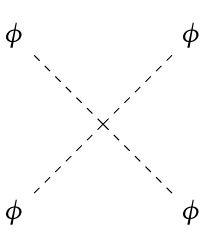
Figure 9: Feynman diagram representing the φ 4